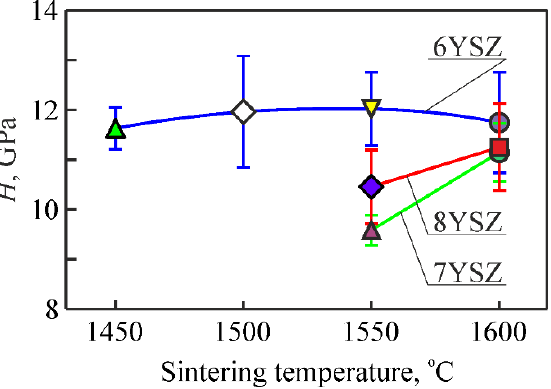
Figure 4. Changes in microhardness of 6YSZ, 7YSZ, and 8YSZ ceramics depending on the sintering temperature (see Table 1). The microhardness was measured under the indentation load of 9.81 N.